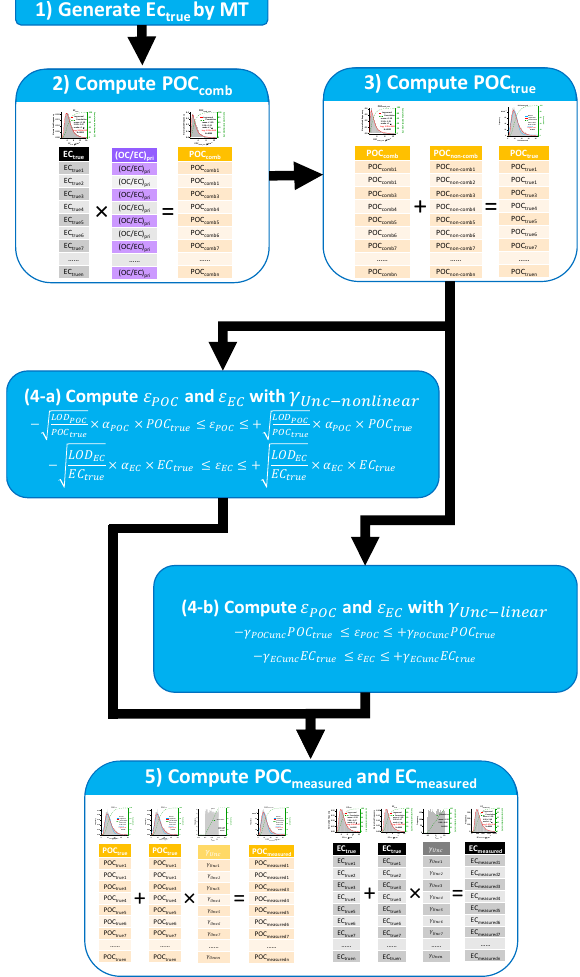
Figure 2. Flowchart of data generation steps using